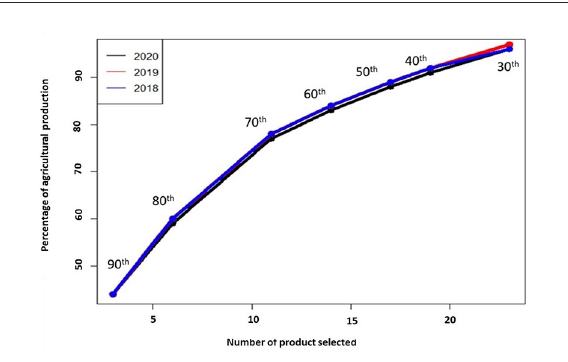
FIGURE3 Comparison between the number of products and share of total horticultural production in the time series of 3